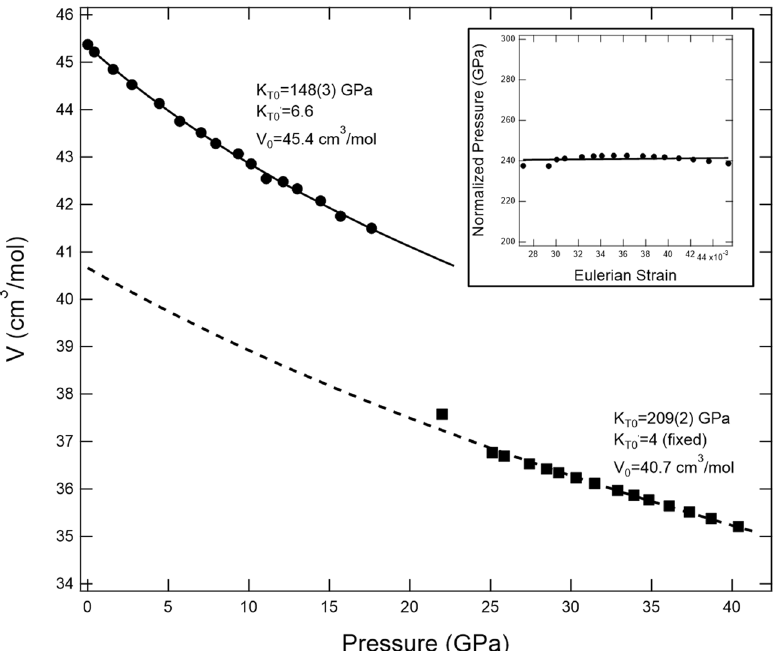
Figure 7. The molar volume as a function of pressure for Mg 2 TiO 4 to 40 GPa. Solid circles represent volumes of cubic phase and solid squares are from high-pressure tetragonal phase. The solid and dashed curves are best-fit third-order Birch-Murnaghan equations of state. The error bars of all data points are smaller than the symbols. The Eulerian strain-normalized pressure plot shows that K T0 ’ of the high-pressure phase is close to 4.